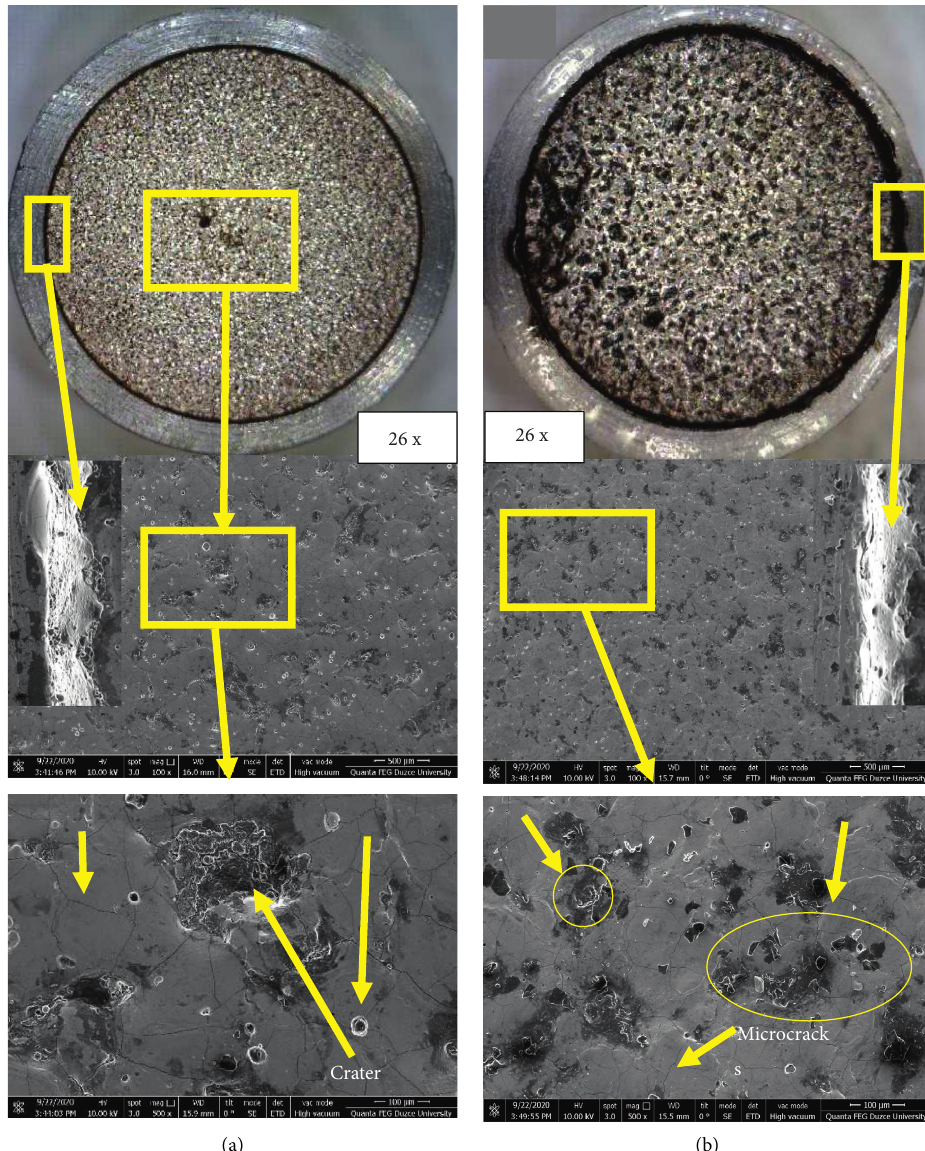
Figure 8: Optical and SEM images of the surfaces having the lowest (a) and highest (b) surface roughness values according to the machining